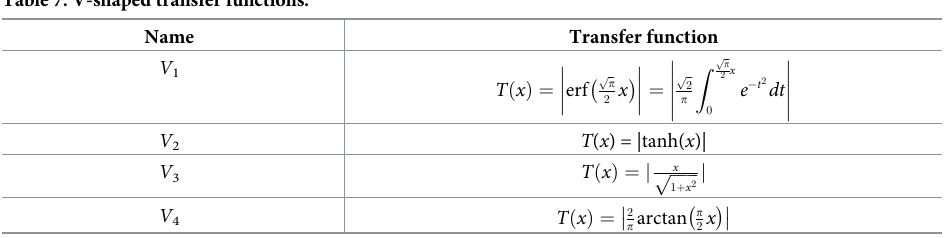
Table 7. V-shaped transfer functions.